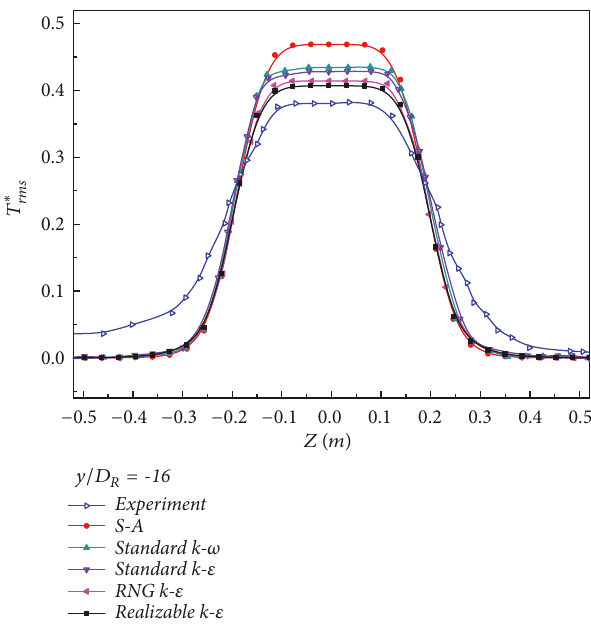
Figure 6: Comparison of dimensionless RMS temperaturebetween numerical data and experimental data in different turbulence models.